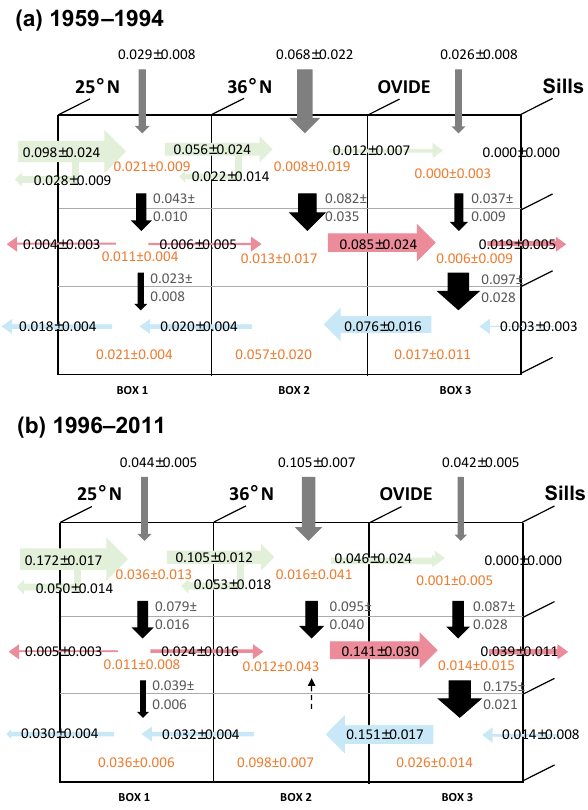
Figure 13. (a) Anthropogenic C budget (PgCyr − 1 ) simulated by the model over the period 1959–1994 for the three water classes and the three boxes (25–36 ◦ N, 36 ◦ N–OVIDE and OVIDE–sills) described in Sect. 4. Horizontal arrows represent the transport of Cant within NACW (Class 1; purple), IW (Class 2; red) and NADW (Class 3; blue) across 25 ◦ N, 36 ◦ N, OVIDE and sills. Grey ver- tical arrows show the air–sea flux of anthropogenic CO 2 for each box. Orange values indicate the subregional Cant storage rate. Black vertical arrows represent the derived vertical transport of Cant be- tween classes. The size of horizontal and vertical arrows is pro- portional to the largest Cant flux estimated over the studied period (i.e. 0.098PgCyr − 1 of Cant incoming across 25 ◦ N within NACW). (b) Same as Fig. 13a but for the period 1996–2011. To compare with Fig. 13a, note that the size of horizontal and vertical arrows is proportional to the Cant flux incoming across 25 ◦ N within NACW over this period